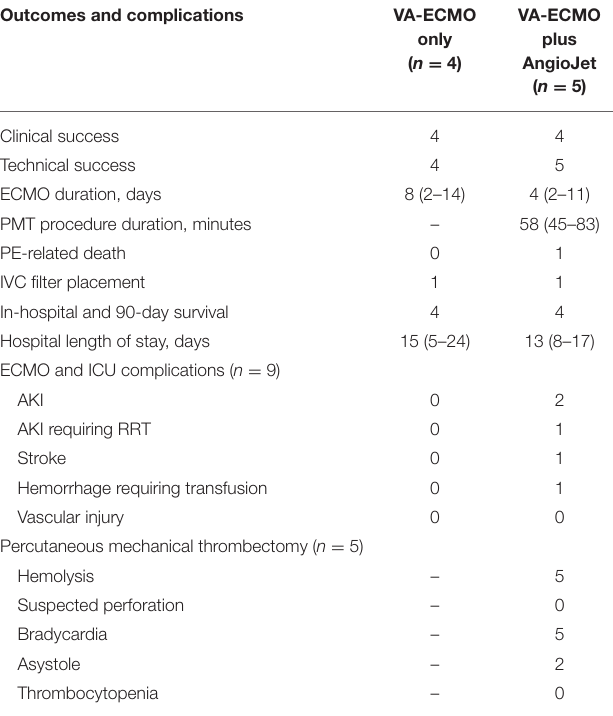
TABLE 5 | Clinical outcomes and complications of patients with acute massive or submassive pulmonary embolism treated with VA-ECMO with or without AngioJet rheolytic